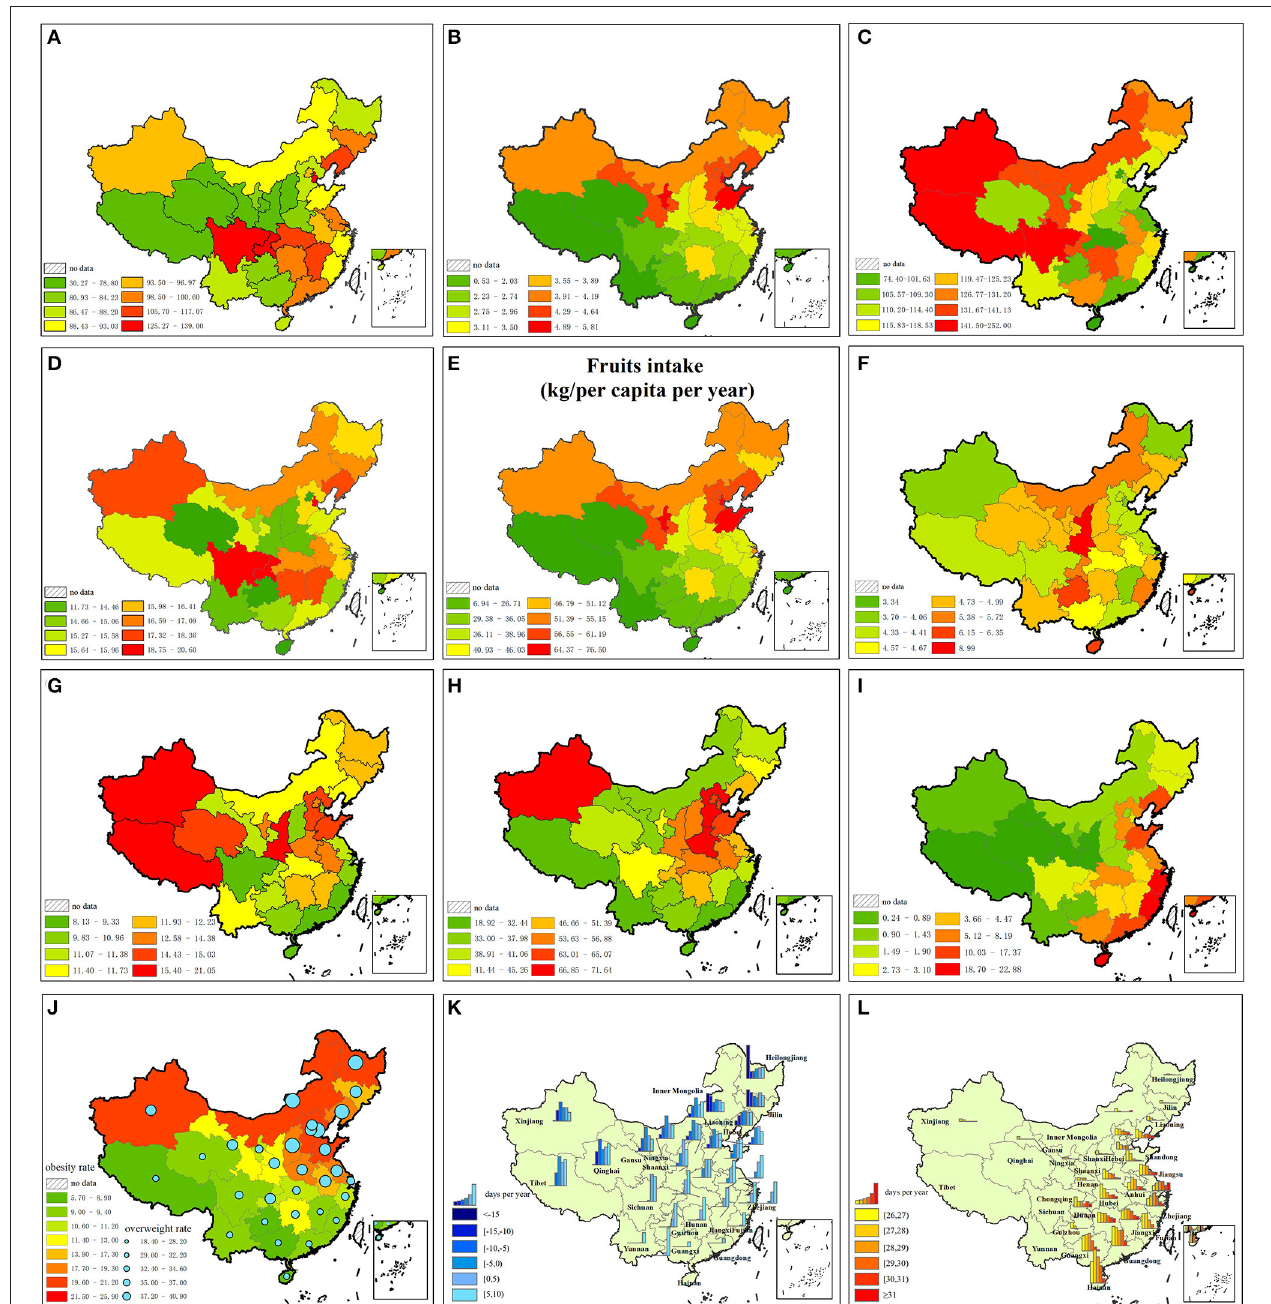
FIGURE 5 | Risk factors for CVD. (A) Diet low in vegetables. (B) Diet low in nuts and seeds. (C) Diet low in whole grains. (D) Diet low in fibre. (E) Diet low in fruits. (F) Smoking. (G) Diet high in sodium. (H) PM2.5. (I) Diet low in seafood omega-3 fatty acids. (J) Obesity. (K) Low temperature. (L) High temperature.